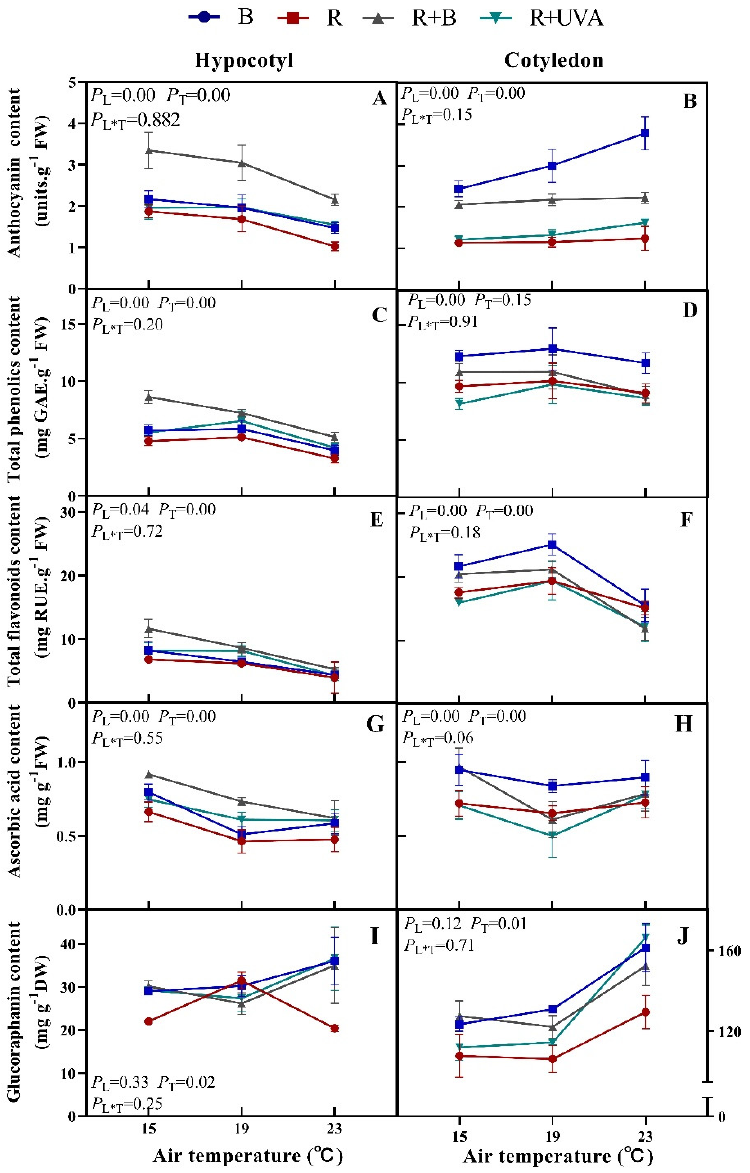
Figure 4. Anthocyanin ( A , B ), total phenolic ( C , D ), total flavonoid ( E , F ), ascorbic acid ( G , H ), and glucoraphanin ( I , J ) contents of broccoli sprouts grown for 5 d under different light [blue (B), red (R), mixture of R and B (R+B), as well as mixture of R and UVA (R+UVA)] and air temperature (15, 19, and 23 °C) regimes. Left panels refer to hypocotyl, and right panels to cotyledon. The difference in the y-axis scale of glucoraphanin content panels ( I , J ) ought to be noted. Error bars indicate SEM (n = 3, each replicate representing the mean of five petri dishes). DW, dry weight; FW, fresh weight; GAE, gallic acid equivalent; RUE, rutin equivalent.